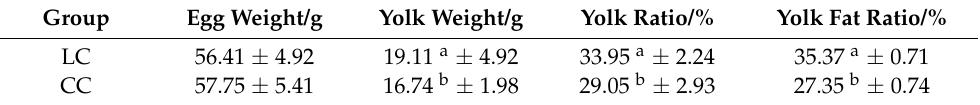
Table 1. Comparison of yolk quality between indigenous chickens and commercial laying hens. Group Egg